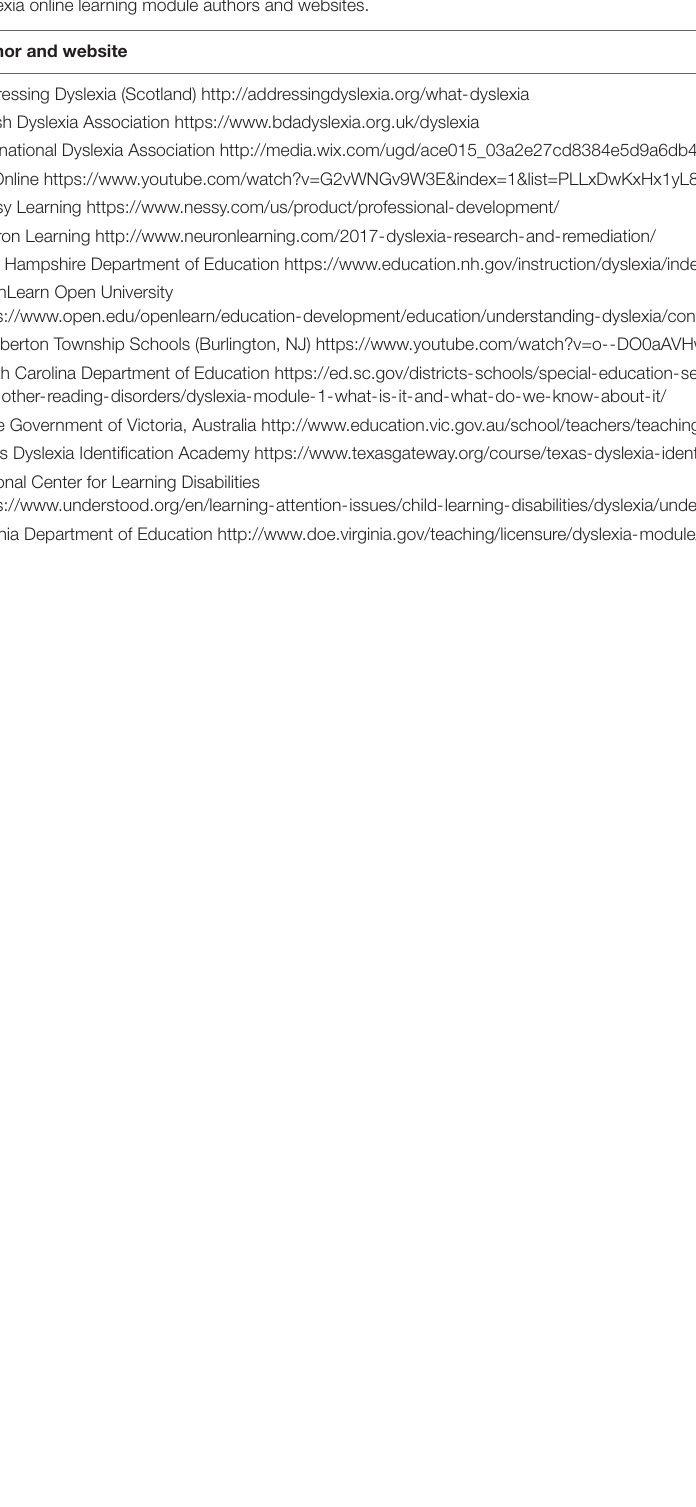
TABLE A1 | Dyslexia online learning module authors and